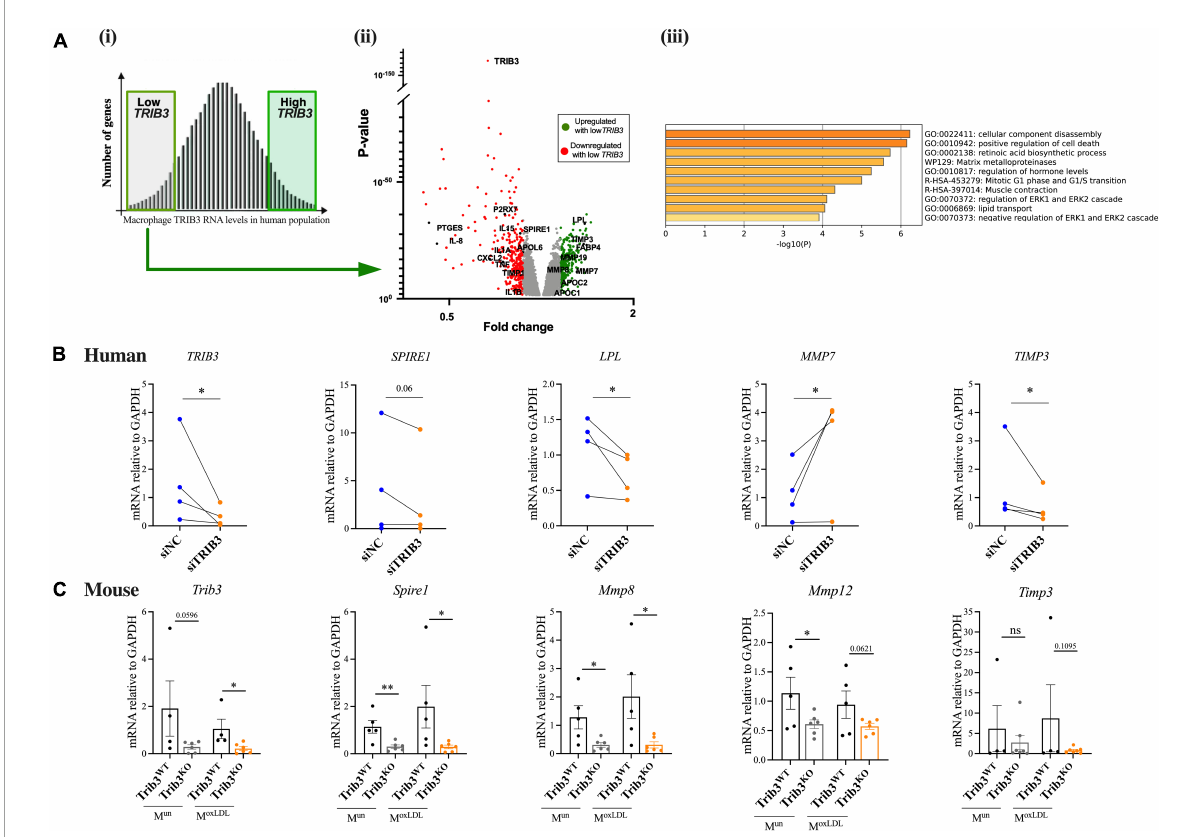
FIGURE5 Loss of TRIB3 alters extracellular matrix remodelling pathways in human and mouse macrophages. (Ai) Microarray data of MDMs from 596 human donors was ranked based on TRIB3 expression and the top high and bottom low expressors were selected for further analysis. (ii) Under a low TRIB3 expression condition, the volcano plot shows the significant genes correlatively expressed with TRIB3, passing the cut off p -value < 0.05 and passing threshold fold change < 0.8 (red—downregulated, so correlatively expressed, with low TRIB3 expression; examples include P2 × 7, PTGES, IL-8, IL15, IL1A, SPIRE1, APOL6, SXSL2, TNF, TIMP1, IL1B ) and > 1.2 (green—upregulated, so inversely correlated, with low TRIB3 expression; examples include LPL, TIMP3, FABP4, MMP19, MMP8, MMP7, APOC2, APOC1 ). (iii) Functional gene set enrichment analysis using Metascape for genes inversely correlated with low TRIB3 expression. (B) si TRIB3 -knockdown mediated changes in mRNA expression levels of genes involved in lipid metabolism (LPL), cytoskeleton and ECM remodelling ( SPIRE1 , MMP7, and TIMP3 ) in human MDMs. Graphs are presented as individual connected points representing one donor, paired student’s T -test, ∗ p < 0.05. (C) Expression of mouse Trib3 and ECM remodelling genes ( Spire1, Mmp8, Mmp12, and Timp3 ) in Trib3 WT and Trib3 KO BMDMs treated or untreated with oxLDL. Graphs are shown as the mean ± SEM ( N = 4–6). Unpaired t -test, ∗ p < 0.05, ∗∗ p < 0.01. GAPDH expression was used as an internal